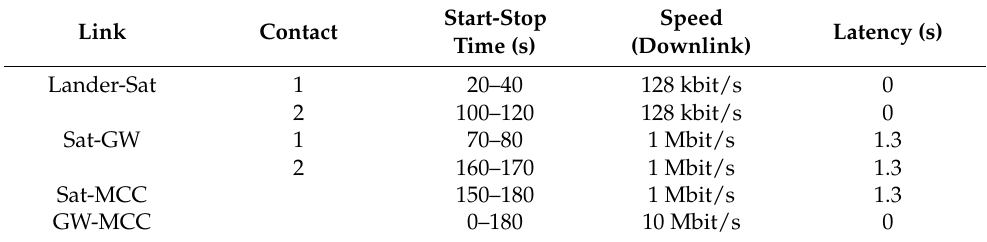
Table 5. Contact plan